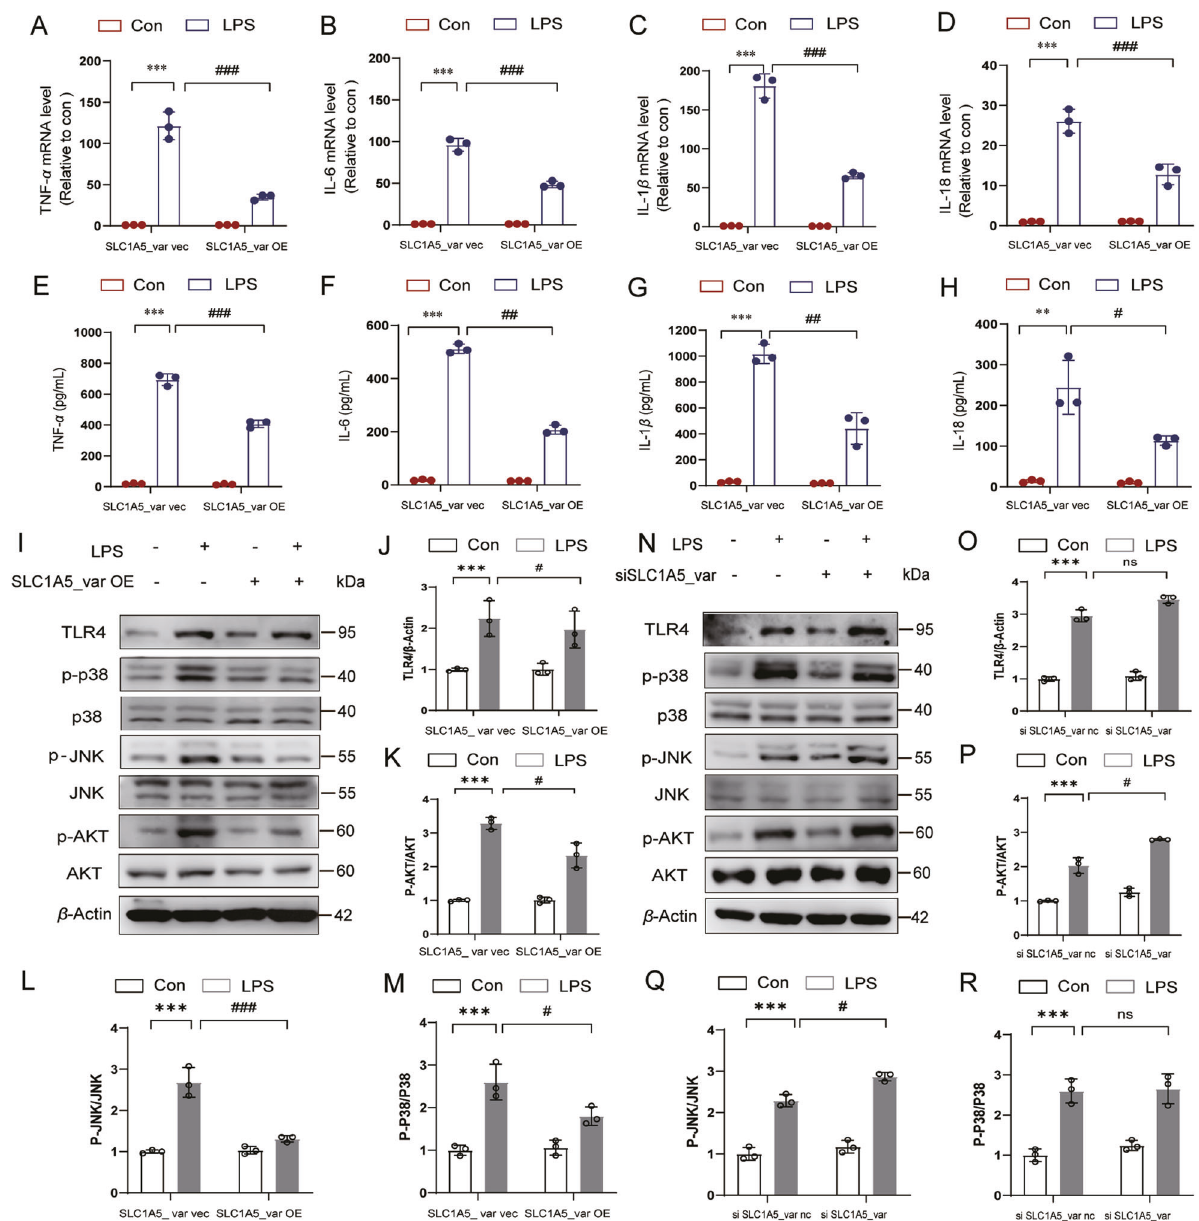
Fig. 6 SLC1A5_var inhibited LPS-induced astrocytic in fl ammatory cytokines and down-regulates TLR4 signal pathway. Astrocytes were transfected with SLC1A5_var (OE) or with SLC1A5_var siRNA for 48 h and stimulated with LPS (100 ng/ml) for 6 h. The mRNA expression levels of Tnf- α ( A ), Il-6 ( B ), Il-1 β ( C ), and Il-18 ( D ) stimulated with LPS were detected by qRT-qPCR( n = 3). Secretion of TNF- α ( E ), IL-6 ( F ), IL-1 β ( G ) and IL- 18 ( H ) in astrocytes stimulated with LPS was detected by ELISA ( n = 3). The protein level of TLR4, p-p38, p-JNK and p-AKT was determined by western blot ( C , F ) while SLC1A5_var was overexpression ( I ) or knockdown ( N ) and quanti fi ed by densitometry ( J – M and O – R ) ( n = 3). Data are shown as the mean ± S.E.M. ** P < 0.01, *** P < 0.001 vs control, ns, P > 0.05, # P < 0.05, ## P < 0.01 and ### P < 0.001 vs LPS group, two-way ANOVA followed by Tukey ’ s post hoc DISCUSSION coordination in this context (Supplementary Fig. S8C). However, Mitochondrial dysfunction and oxidative stress have been recognized the defect of motor coordination of LPS-treated mice was as major contributors to the death of DA neurons in PD. Although it observed in pole test, and attenuated by SLC1A5_var over- has been increasingly clear that mitochondrial dysfunction in expression (Supplementary Fig. S8D). Meanwhile, from the HPLC astrocytes triggers neuroin fl ammation underlying the development analysis, the reduced dopamine level was reversed by SLC1A5_var of PD [25, 26], sophisticated regulation of mitochondrial function overexpression (Supplementary Fig. S8E). Consistent with the fi ndings in the MPTP model, overexpression of SLC1A5_var also within astrocytes remains largely unknown. In this study, by replicating mitochondrial dysfunction and oxidative stress in rescued loss of dopaminergic neurons in the LPS model astrocytes, we identi fi ed that SLC1A5_var is required for mitochon- (Supplementary Fig. S8F, G). Overall, these data suggest that drial energy metabolism. More importantly, genetic manipulation of SLC1A5_var elicits the neuroprotective effect via alleviating the SLC1A5_var further validated its bene fi cial effects on PD pathology. neuroin fl ammation in the LPS-induced PD model.